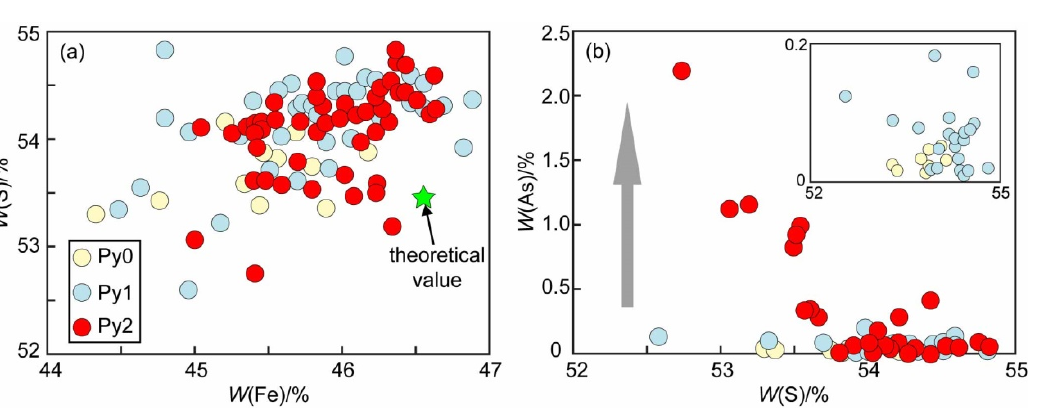
Figure 5. The plots of main elemental contents of pyrites in the Xinjiazui gold deposit, including ( a ) w (S) vs. w (Fe) and ( b ) w (As) vs. w (S) diagrams. Table 1. Electron probe analyses of different types of pyrites in the Xinjiazui gold deposit. Py0 (0.013% to 0.055%) and Py1 (0.007% to 0.181%) contain similar As content, and both are lower than that of Py2 (0.003% to 2.228%, Figure 5b). The variation of As contents reflect the evolution of the ore-forming fluid composition, so the subtle differences in As content of Py0, Py1, and Py2 indicate that the ore-forming fluids are more enriched in As. Moreover, there is an obvious negative correlation between the As and S in pyrite (Figure 5b), suggesting that As replaces S in pyrite [48].